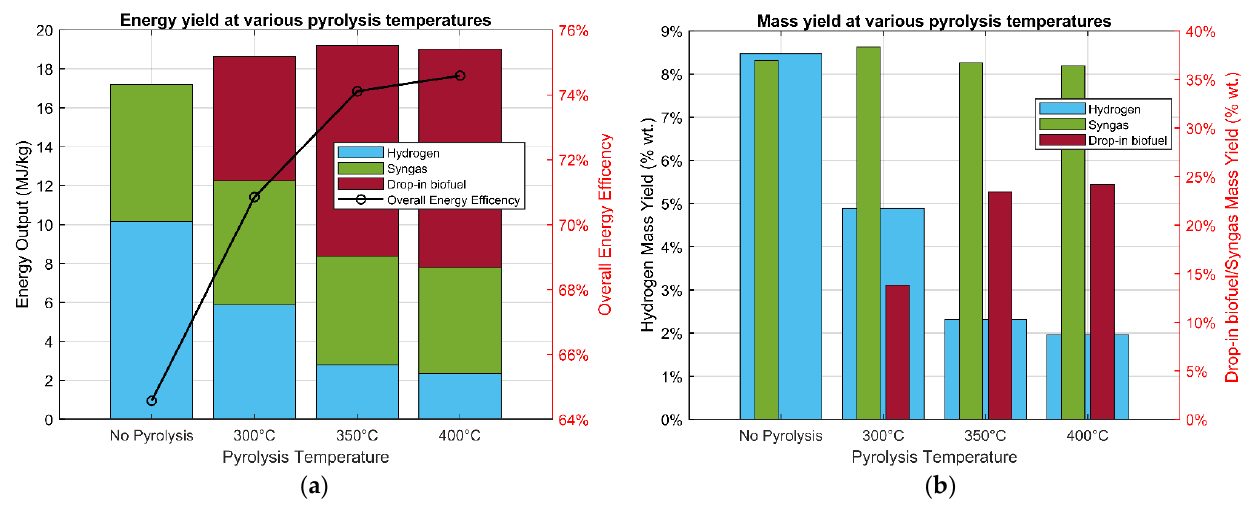
Figure 7. Performance parameters of the system ( a ) Energy output and overall energy efficiency as pyrolysis temperature changes ( b ) Mass output yields as pyrolysis temperature changes .